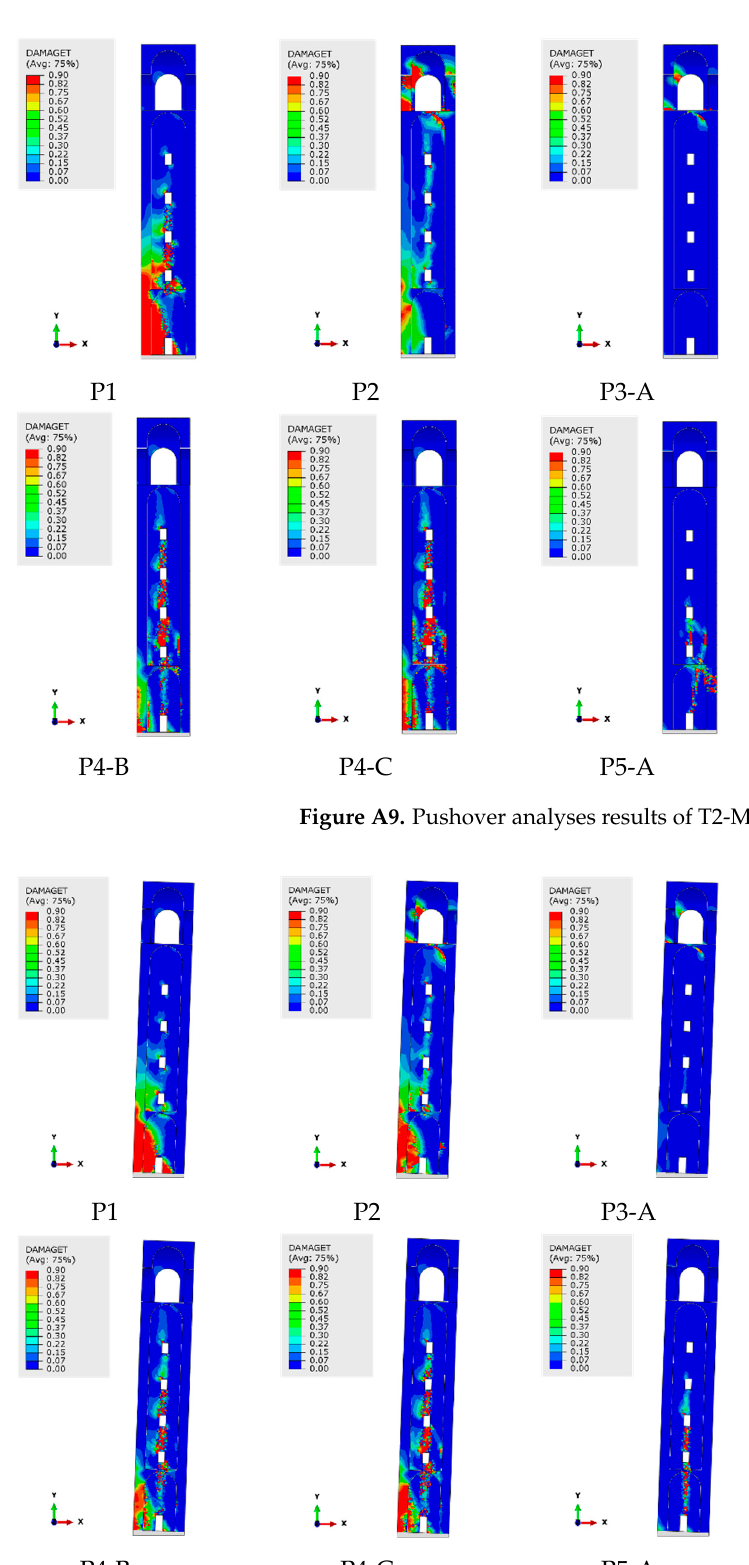
Figure B7. Pushover analyses results of T3-M1—Damage patterns. Figure A10. Pushover analyses results of T3-M1—Damage